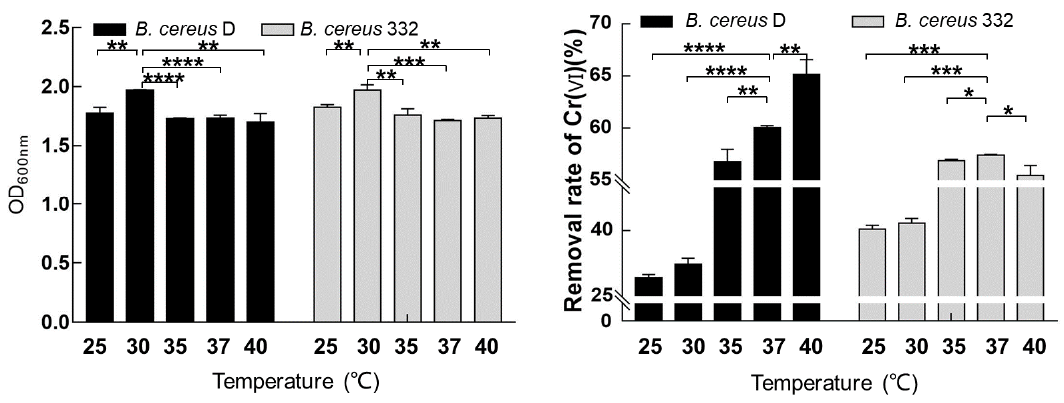
Figure 5. The e ff ects of temperature on the growth ( A ) and the chromium-reducing capacity ( B ) of B. cereus D and B. cereus 332. **** indicates p < 0.0001, *** indicates p < 0.001, ** indicates p < 0.01, and * indicates p < 0.05.